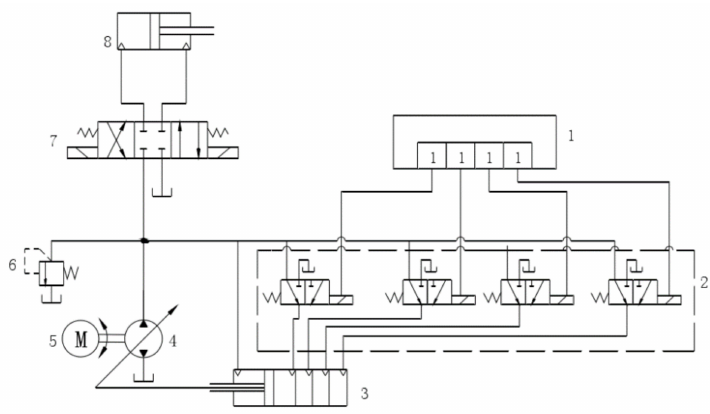
Figure 9. The digital hydraulic pump controlled by the combination